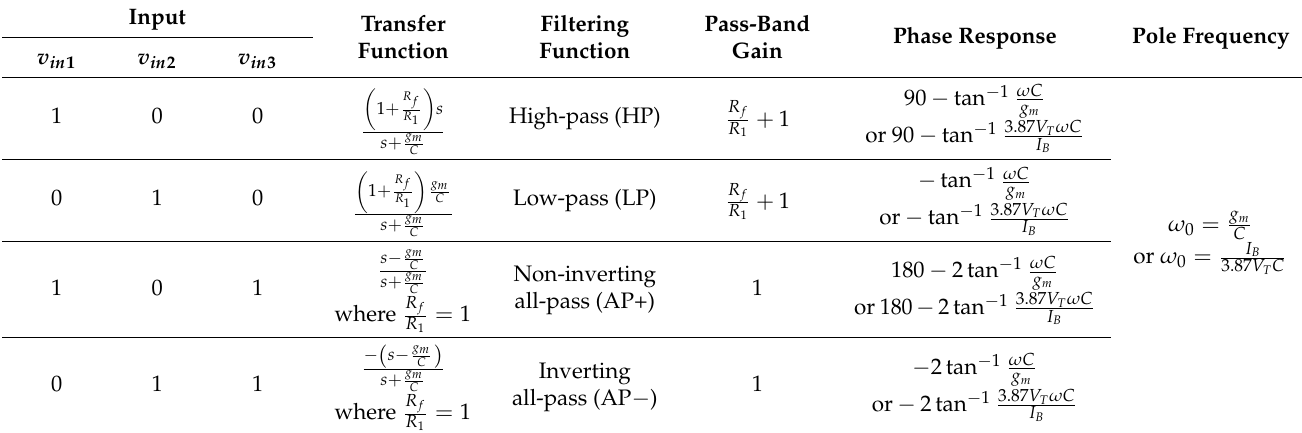
Table 2. The selection of each filtering response and filtering